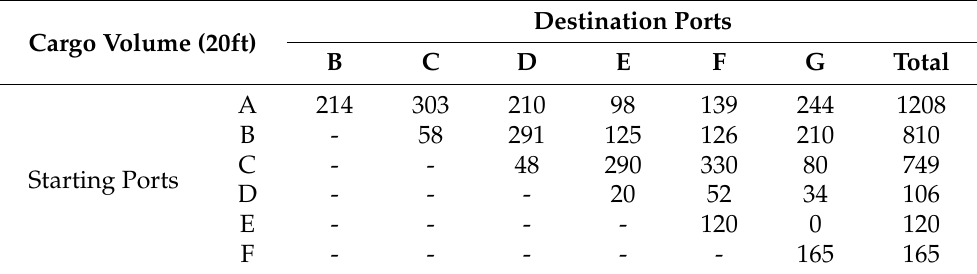
Table 3. Number of 20-foot export containers in each port (unit: TEU). Cargo Volume (20ft)